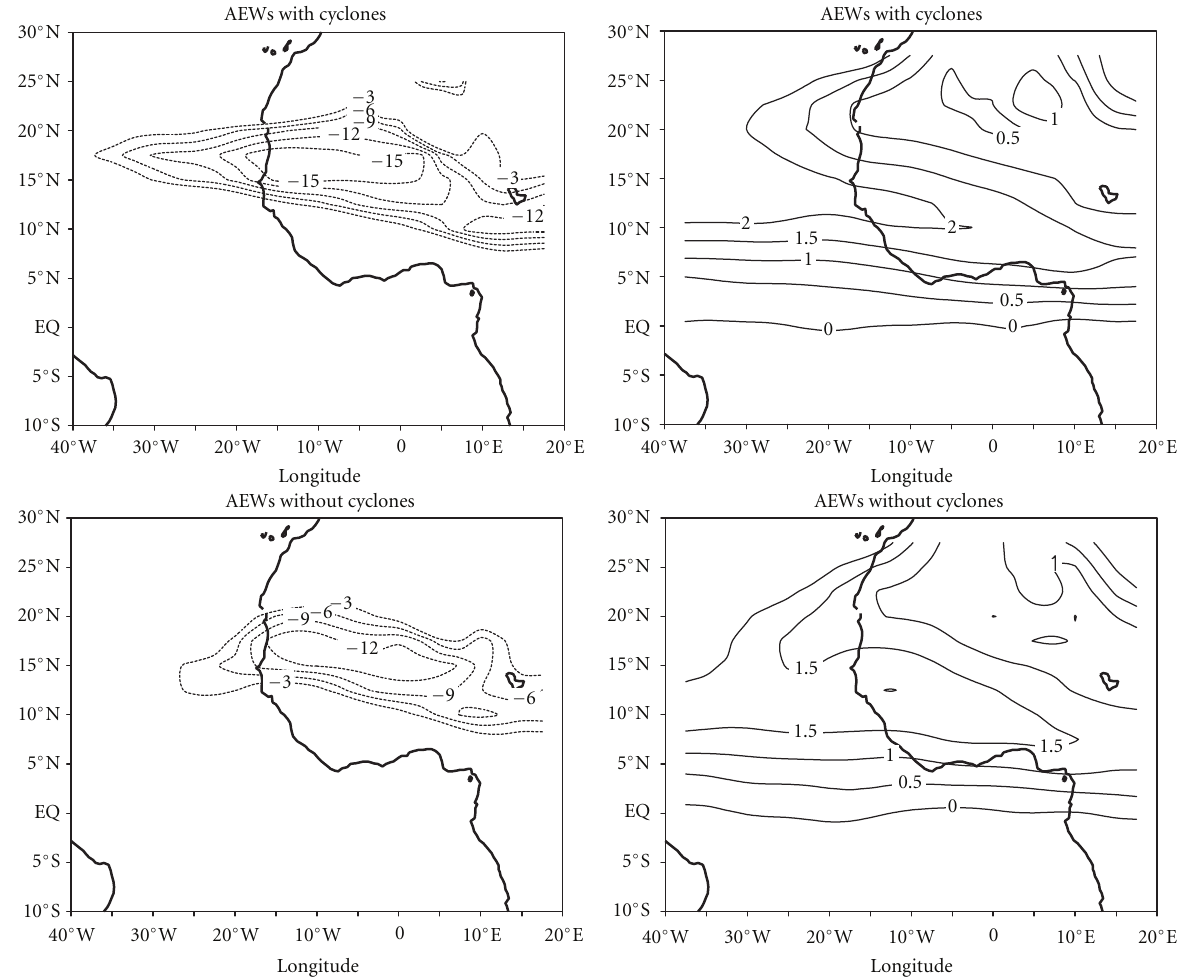
Figure 4: Meridional gradient of Potential Vorticity (left) and Potential Vorticity (right) at 315-K isentropic surface for AEWs associated with cyclones (top) and for non-developing AEWs (AEWs not associated with cyclones (bottom)). Units are PVU for the PV and 0, 01PVU/100km for the meridional gradient of PV. 1PVU = 10 − 7 m 2 K s − 1 kg − 1 .